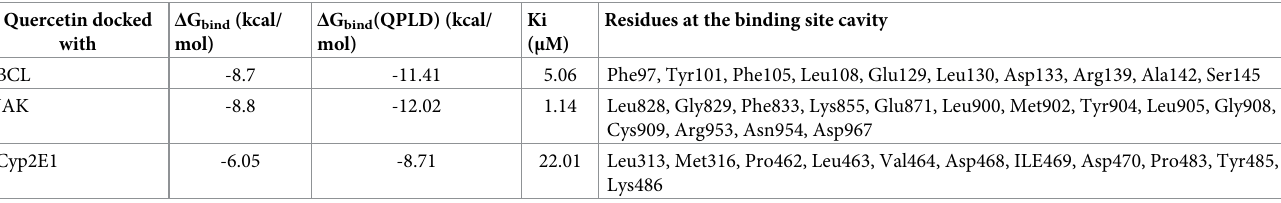
Ki Residues at the binding site ( μ M)